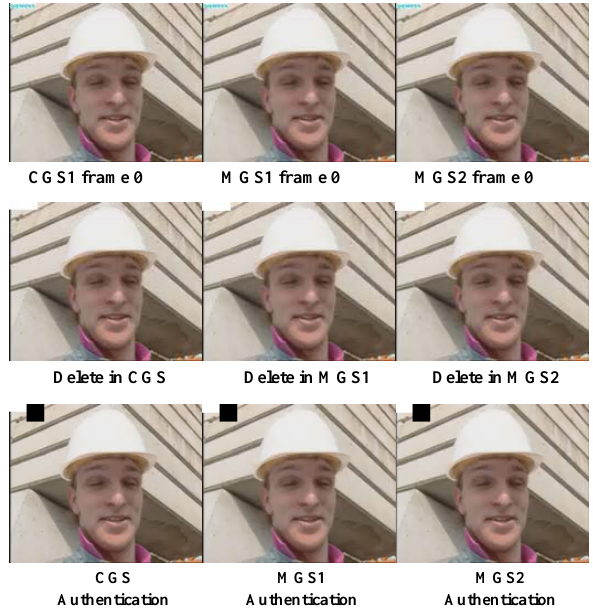
Figure 7. Tampers (delete and replacement) in base layer frame 0 and authentication